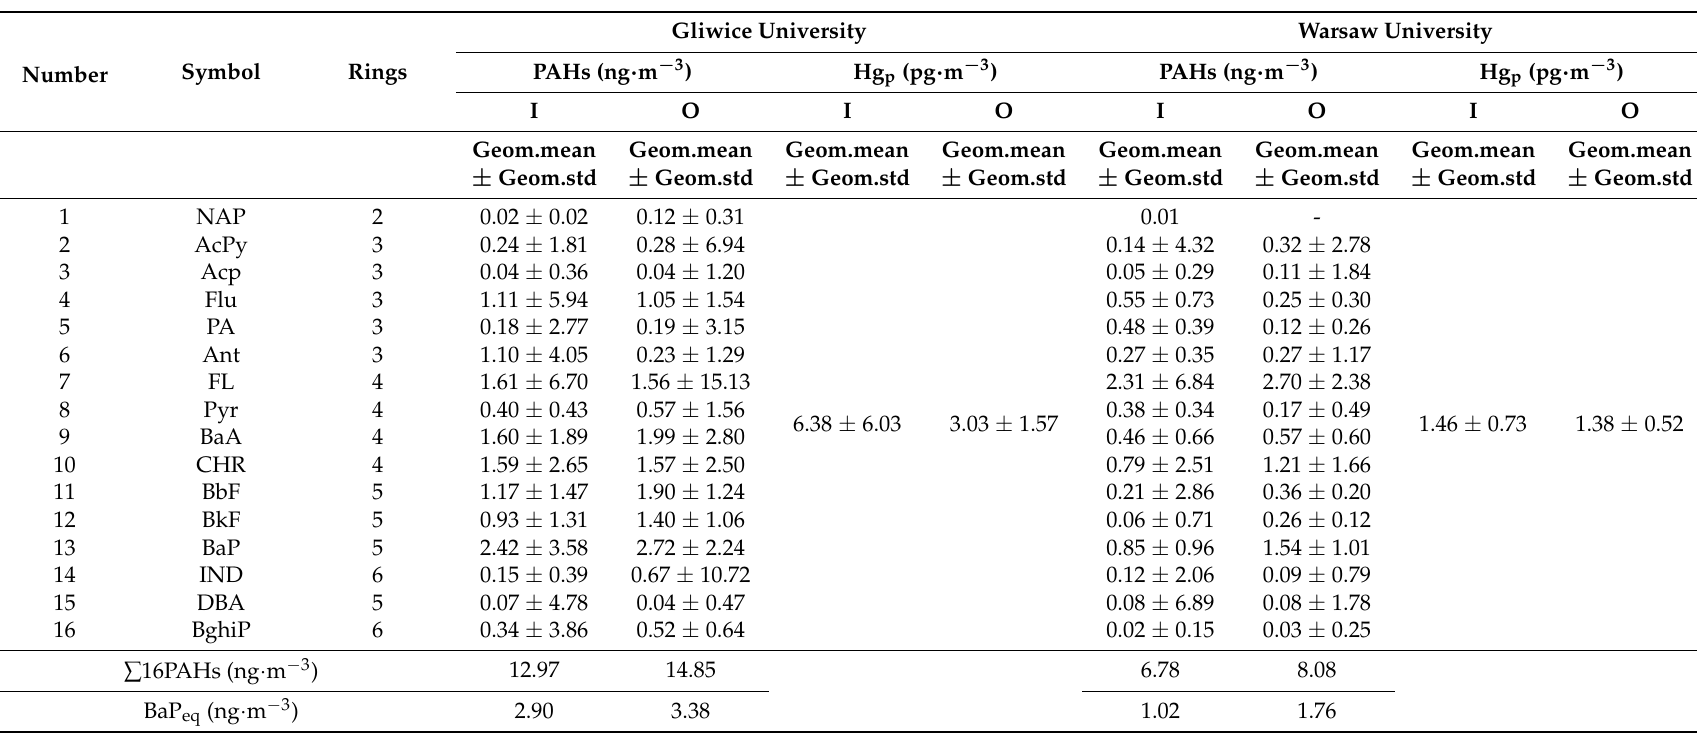
Table 3. The geometric mean and geometric standard deviations from the 24-h concentrations of 16 PAHs (ng · m − 3 ) and Hg p (pg · m − 3 ) in the indoor (I) and outdoor (O) environments of a specific